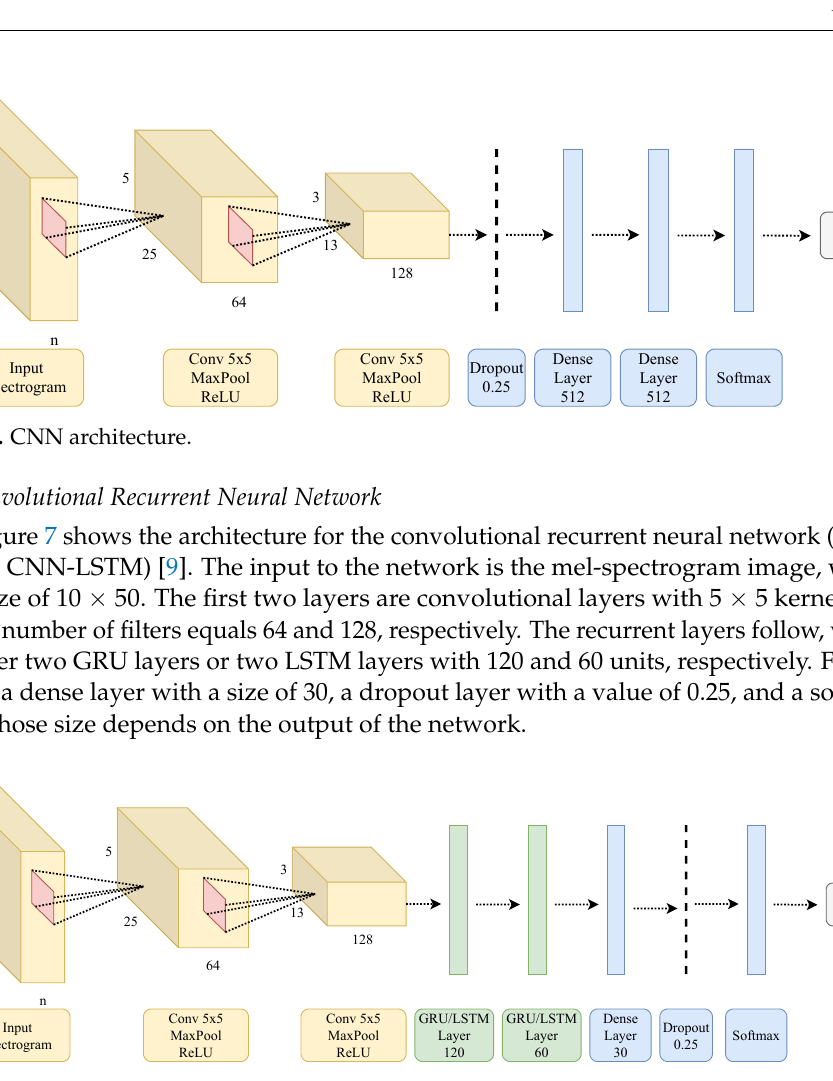
Figure 7. CNN-(LSTM/GRU)